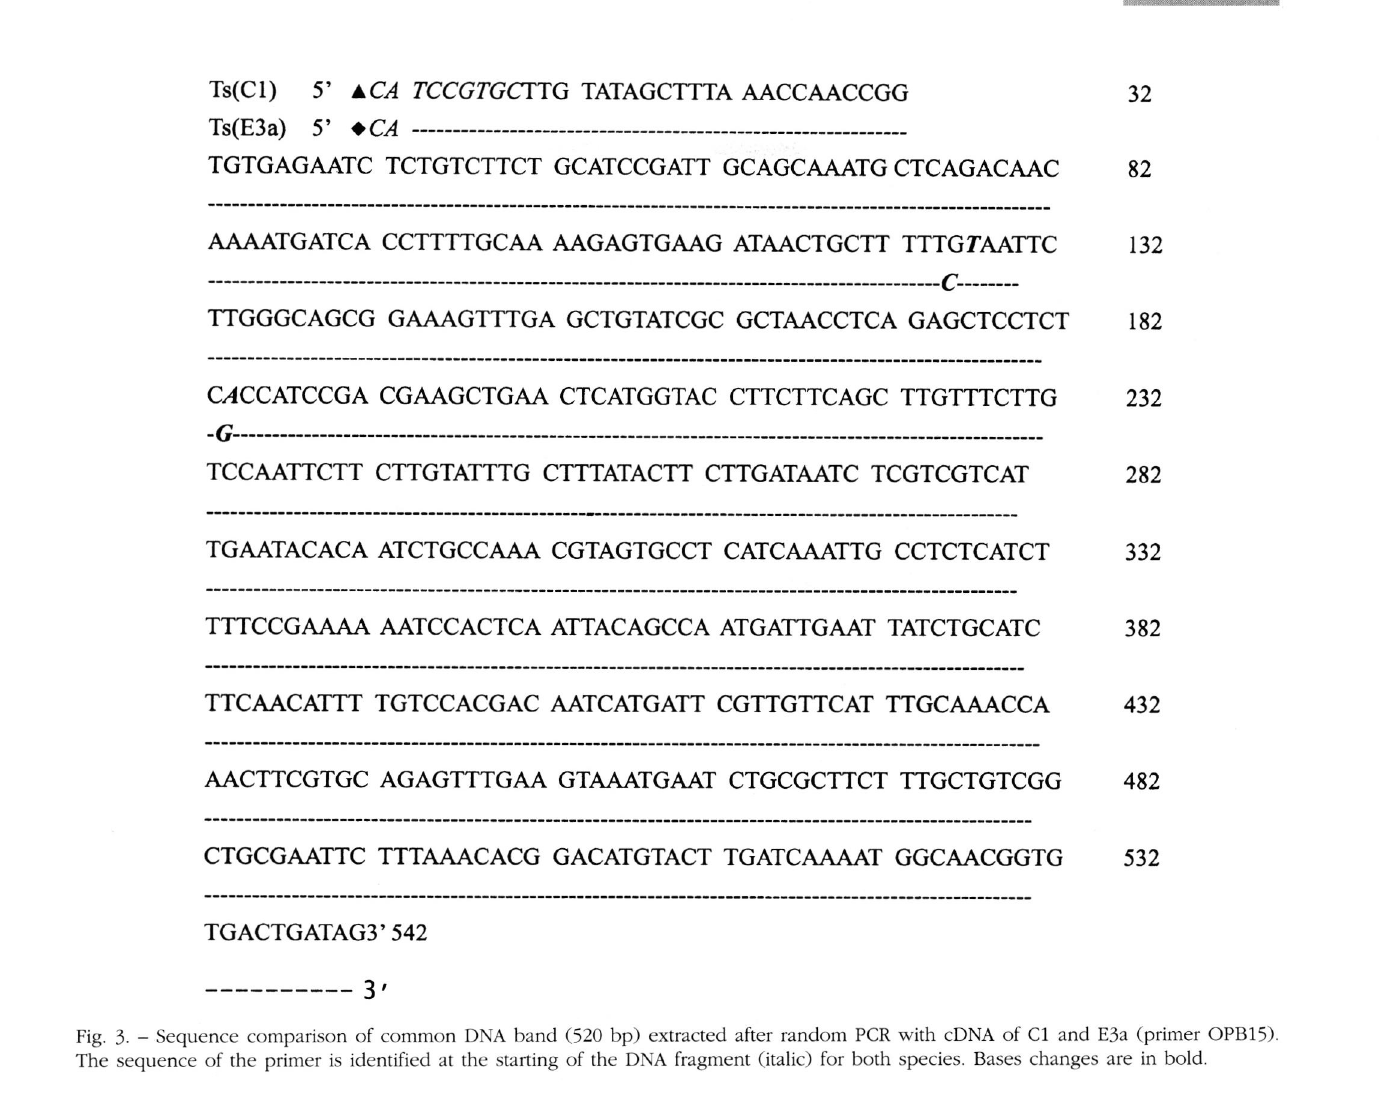
the adult worms of all species release NBL on day